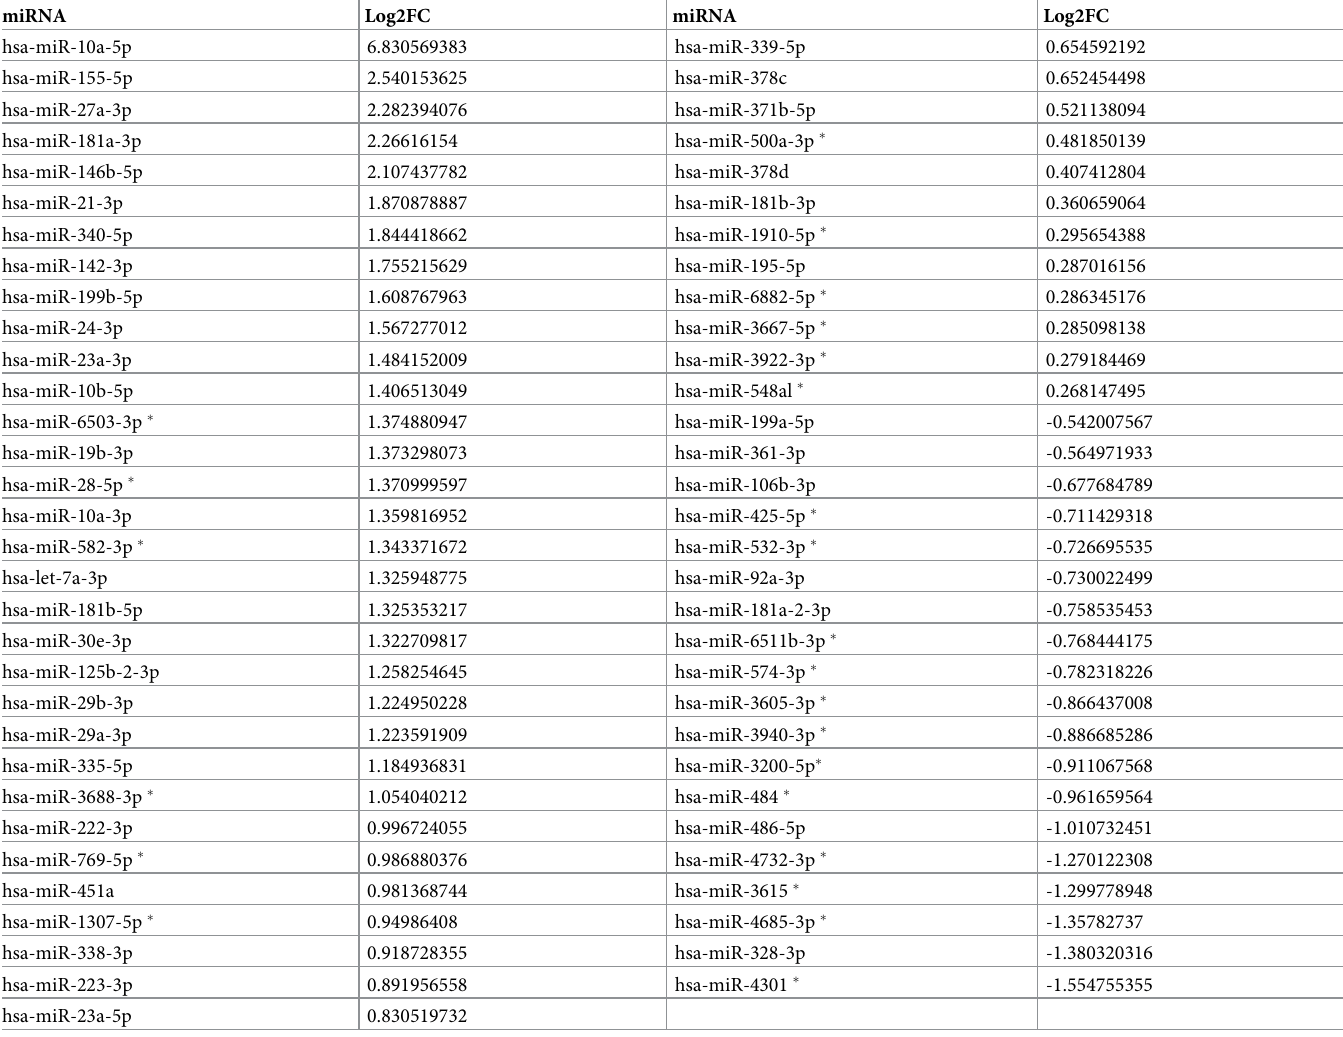
Table 3. Differential expression of miRNAs between NPM1+/FLT3+ AML patients and